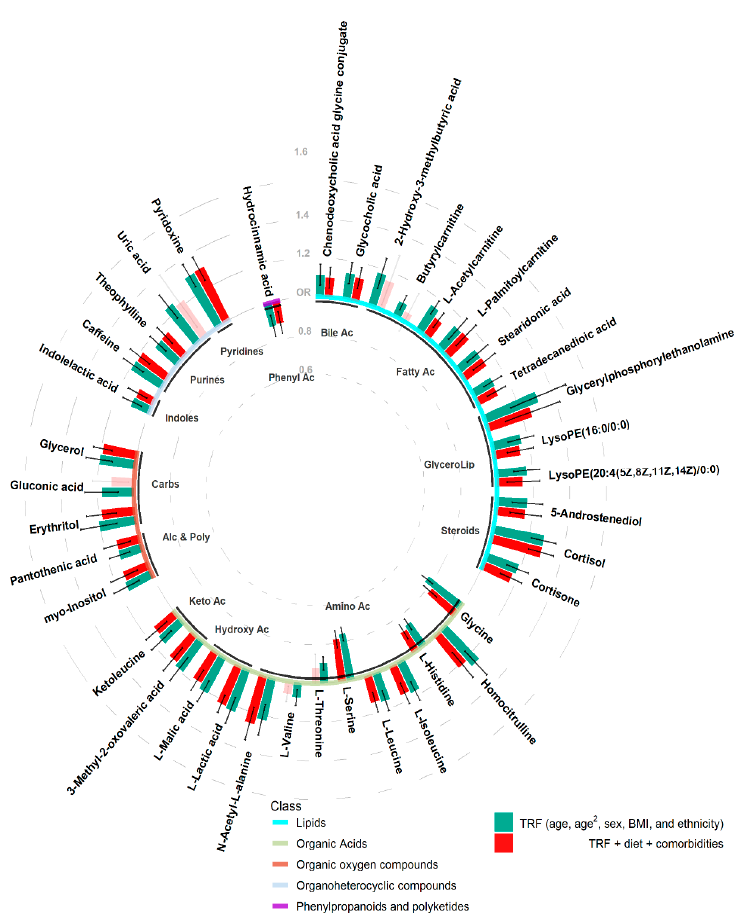
Figure 2. Odds ratio’s and 95% confidence intervals of hypertension associated metabolites adjusting for traditional risk factors (TRF) (green) or TRF + diet + comorbidities (red). Semi-transparent bars illustrate analyses not passing the pre ‐ defined alpha threshold. Base line colours represent the super class of metabolites, while sub ‐ base labels indicate the metabolite sub class.